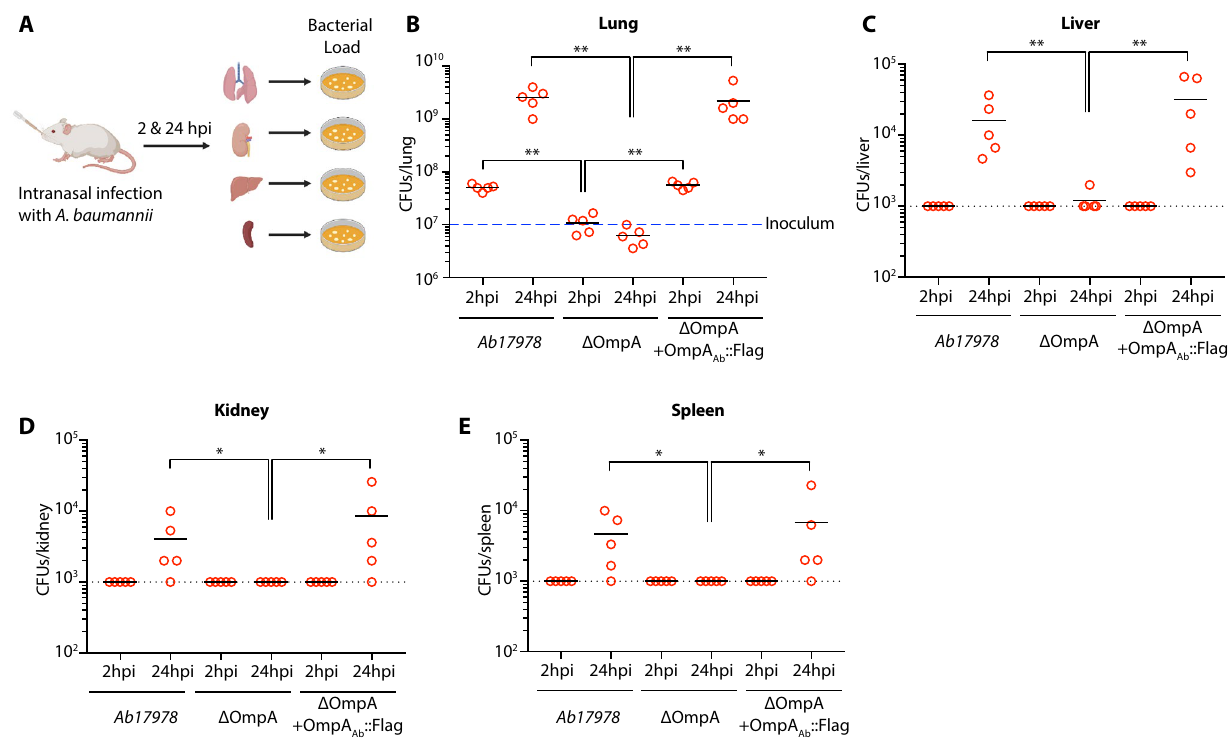
Figure 1. OmpA Ab is required for bacterial colonization and dissemination in vivo . ( A ) Schematic representation of the mouse infection (created with BioRender.com). ( B – E ) Neutropenic BALB/c mice were infected intranasally with 10 7 colony forming units (CFUs) of the indicated bacteria. Each group included five mice per time point. Two- and 24-h post-infection, animals were euthanized and lungs, liver, kidneys and spleen were homogenized and CFUs were plated from these organs. Blue dashed line in ( B ) represents the CFU with which each mouse was infected with. Black dotted line in ( C – E ) represents the limit of detection. Shown is the representative data from two independent experiments. Two-tailed p value using Mann–Whitney test * p ≤ 0.05, ** p ≤